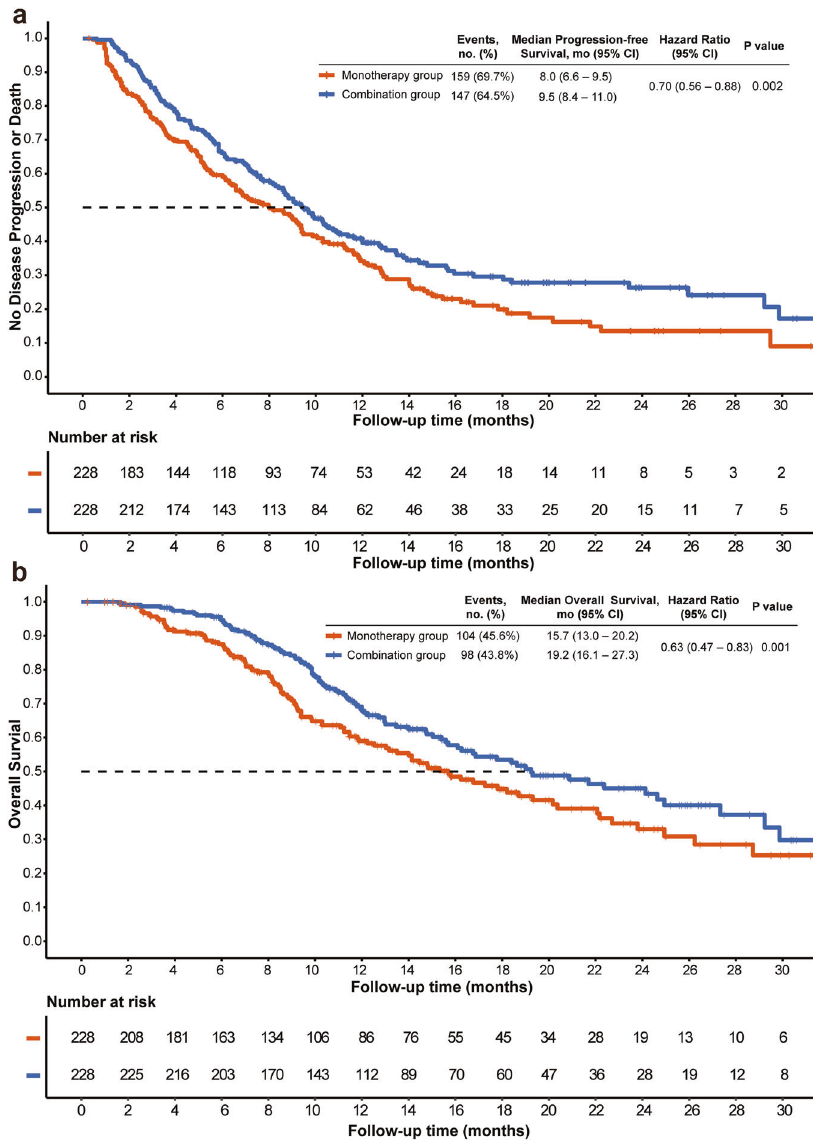
Fig. 2 Kaplan – Meier analysis of progression-free survival ( a ) and overall survival ( b ) The ef fi cacy bene fi ts of TACE with PD-(L)1 inhibitors plus MTT were generally consistent across clinical subgroups, including those of relevance to HCC (ECOG performance status, HBV etiology, baseline tumor burden, and the with or without macrovascular invasion and/or extrahepatic spread). Besides, early combination therapy is expected to lead to greater potential gain than those who had previous treatment history. As these were subgroup analyses, these fi ndings should be interpreted with caution. All AEs from any cause were reported in 98.2% and 99% of patients receiving PD-(L)1 inhibitors plus MTT, while grade ≥ 3 AEs were 61.6% and 56% in the IMbrave 150 and ORIENT-32 trials, respectively. 20,21 Most AEs were mild-to-moderate severity and readily managed or reversible in our study, with a small percentage of patients discontinuing PD-(L)1 inhibitors (5.7%) or molecular targeted agents (11.8%) due to AEs. There are rationales for the combination of TACE with PD-(L)1 inhibitors plus MTT. 28,29 First, TACE induces hypoxia microenvir- onment and VEGF elevation expression in the residual surviving cancerous tissue. 30 Antiangiogenic therapy (antibodies targeting